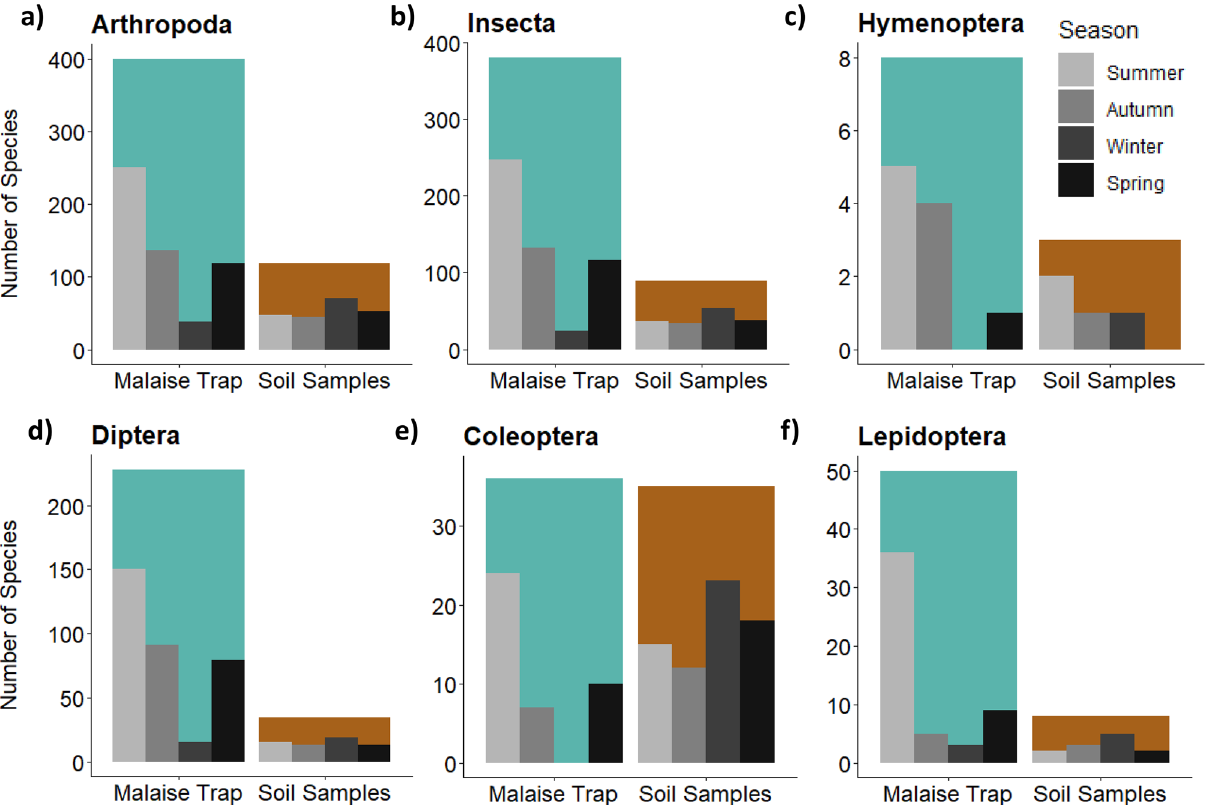
Figure 2. Number of arthropod species detected (blastID ≥ 99%) per sample type depending on sampling season. The colored bars indicate the total number of species detected in Malaise traps (blue) and soil samples (brown), irrespective of forest type and season. The grey shaded bars represent numbers of detected species in spring (lightest grey), summer (mid-grey), autumn (dark-grey) and winter detected in the Malaise trap catches. The ten species exclusively recovered from the soil samples are all members of ground dwelling genera 21,22 . Although flying insects are more likely to be detected within the Malaise trap catches, four dipteran species were exclusively found in the soil samples, possibly as eggs or larvae. The reasons why these four dipteran species were absent from the Malaise traps could be manifold. As well as known methodological issues such as primer and biomass biases 23–25 a total of 8 weeks of Malaise trapping only allows for a short glimpse of the existing flying arthropod diversity, and species with a short flight period are especially prone to be missed. For example, flying adults of two lepidopterans Nematopogon robertella and Nemophora congruella are usually observed in Germany between May and June (gbif.org), an interval during which Malaise sampling was not conducted. As well as an association of species with the habitat, the time of sampling directly influenced species detection rates. Due to the poikilothermic character of arthropods 1 but also due to fluctuations in food availability 26 , there is a wide consensus that arthropod and in particular insect diversity is directly linked to time of year. In this study, we observed different seasonal dynamics in arthropod communities collected from the soil and by Malaise traps. While species diversity in Malaise traps was higher during summer, species diversity associated with the soil habitat increased in the colder seasons. Flying arthropods, e.g. dipterans, hymenopterans and lepidopterans are especially active during the warm summer months 1 , which was mirrored by the high number of arthropod species found in the Malaise trap catches during the summer season. Due to decreasing temperatures and low light levels of the winter months, many insects enter a hibernation state in late autumn. While some insects prefer the bark of trees, dead wood, hedges and meadows for hibernation, many others hibernate in leaf litter or dig soil chambers. As a result, an accumulation of arthropod species was observed in soil samples during winter, highlighting the importance of soil habitats for arthropod conservation strategies. Additionally, it must be kept in mind that in contrast to Malaise traps eDNA can persist in the soil for several weeks, and the metabarcoding of soil eDNA will allow the detection of eggs, larvae and organisms that might have already entered a state of inactivity at the time of sampling. Arthropod community composition associated with the ground layer was more driven by forest type, while communities associated with the above ground habitat showed significant differences also between seasons. We also observed that species assessed with Malaise traps were more likely to be found in several habitats within one season. This is likely due to the fact that flying organisms range wider while ground dwelling organisms are more sessile. The sample completeness curves support these assumptions, where the above ground arthropod diversity using Malaise traps requires a comparatively lower sampling effort than the assessment of the ground